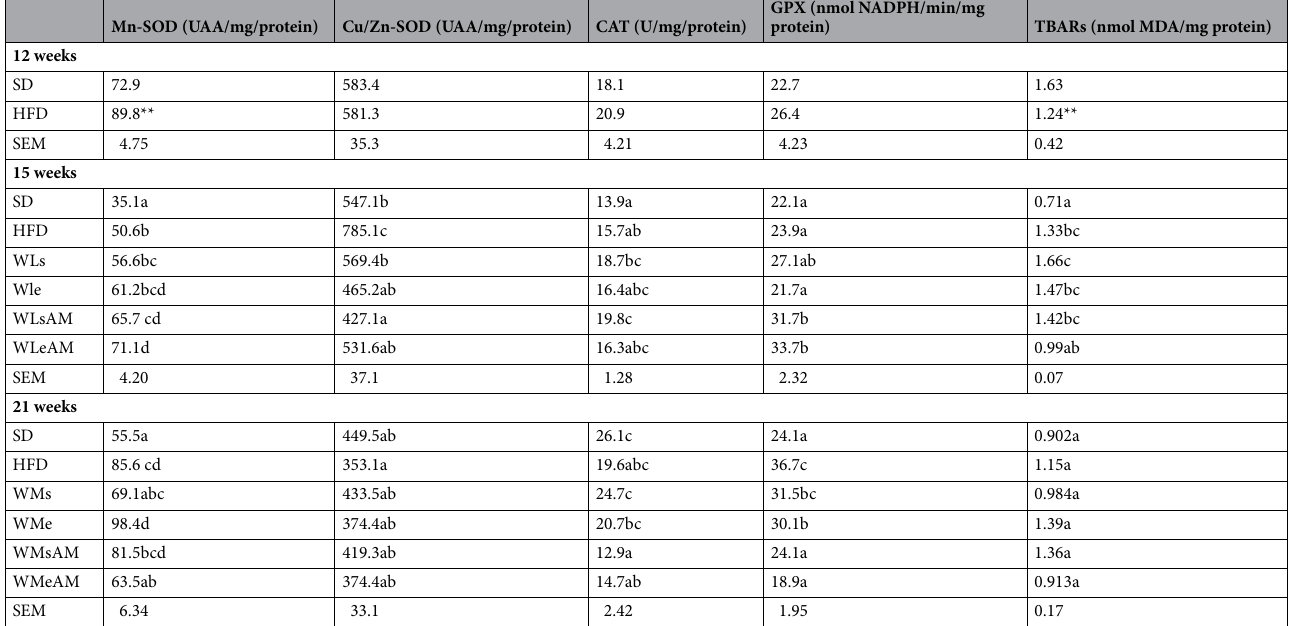
Table 4. Effects of DIO and weight control interventions on kidney antioxidant activities and lipid peroxidation. SD standard rat chow diet, HFD hypercaloric diet for dietary induction of obesity, WLs high protein weight-loss intervention diet with a sedentary lifestyle (weeks 12–15), WLe high protein weight-loss intervention diet with training protocol, WLsAM high protein weight-loss intervention diet with a sedentary lifestyle and pharmacological treatment with AM251, WLeAM high protein weight-loss intervention diet with training protocol and pharmacological treatment with AM251. WMs high protein weight-loss intervention diet with a sedentary lifestyle (weeks 12–15) followed by weight-maintenance stage (weeks 15–21) with SD dietary treatment and sedentary lifestyle, WMe high protein weight-loss intervention diet with training protocol followed by weight-maintenance stage with SD dietary treatment and training protocol, WMsAM high protein weight-loss intervention diet with a sedentary lifestyle and pharmacological treatment with AM251 followed by weight-maintenance stage with SD dietary treatment, sedentary lifestyle, and pharmacological treatment with AM251, WMeAM high protein weight-loss intervention diet with training protocol and pharmacological treatment with AM251 followed by weight-maintenance stage with SD dietary treatment, training protocol, and pharmacological treatment with AM251. SOD superoxide dismutase (Units/mg protein), CAT catalase (Units/mg protein), GPX glutathione peroxidase (nmol NADPH/min/mg protein), TBARS thiobarbituric acid reactive substances (nmol MDA/mg protein). Results are means of 8 rats. SEM standard error of the